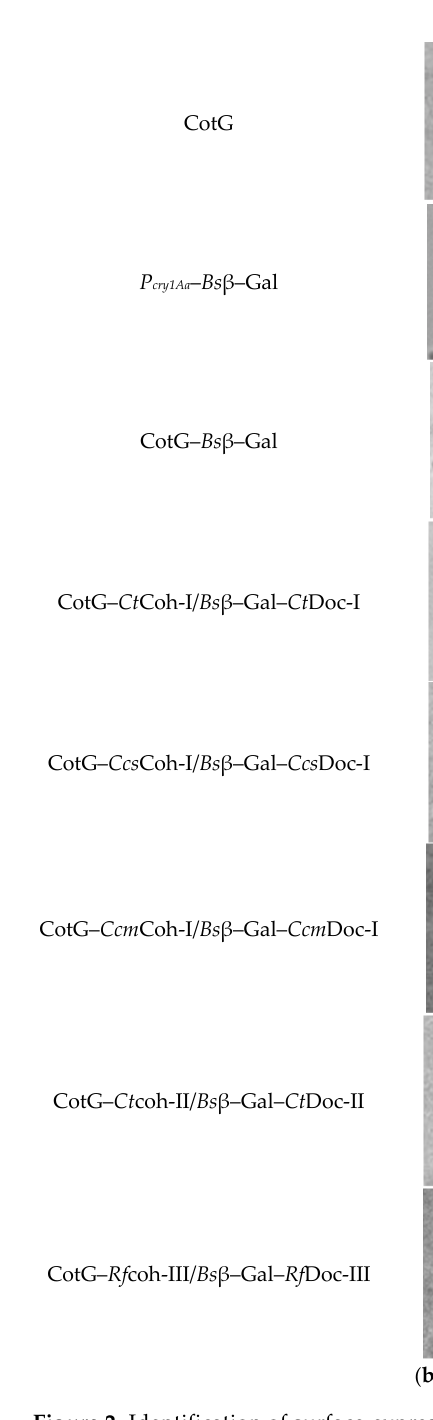
Figure 2. Identification of surface-expression of CotG–Coh ( a ) and CotG–Coh/ Bs β –Gal–Doc ( b ) by immunofluorescence microscopy analysis. After being labeled with rabbit polyclonal anti– Bs β –Gal antibody, purified spores carrying CotG–Coh were imaged with fluorescent microscopy. The same procedure was applied on the spores carrying CotG–Coh/ Bs β –Gal–Doc, except that they were labeled with anti– Bs β –Gal–Alexa Fluor 488. Spores obtained with B. subtilis WB600/pEB03-cotG served as a negative control. BF and IF, bright field and immunofluorescence images, respectively. Scale bar, 20 µ